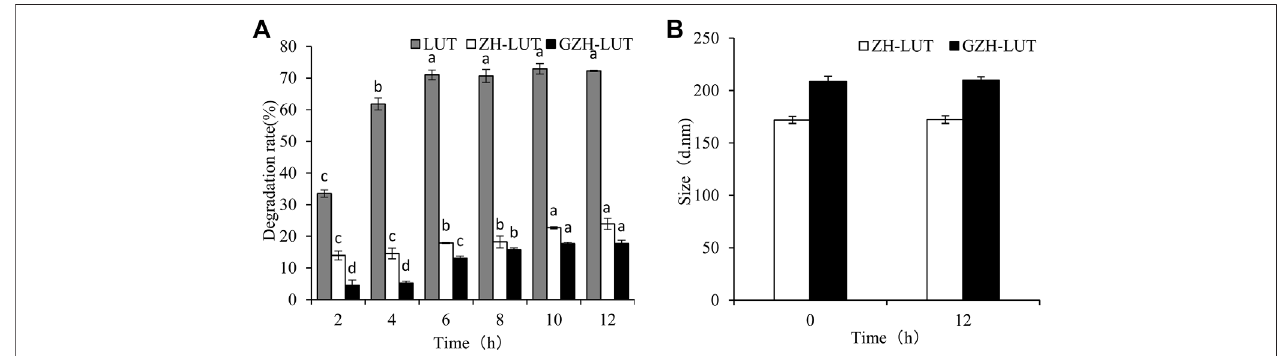
FIGURE 9 | Effects of light radiation on the stability of free lutein, ZH-LUT and GZH-LUT nanoparticles (A,B) .